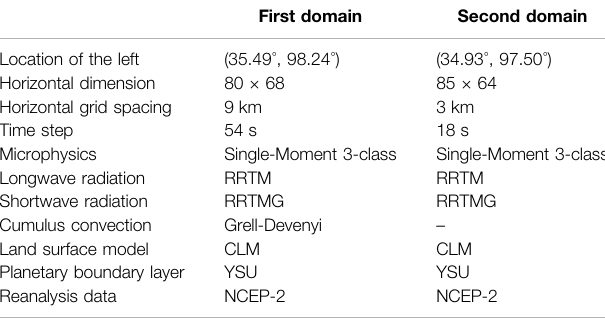
TABLE 1 | Model con fi gurations for the two nested domain and parameterization schemes used in the WRF